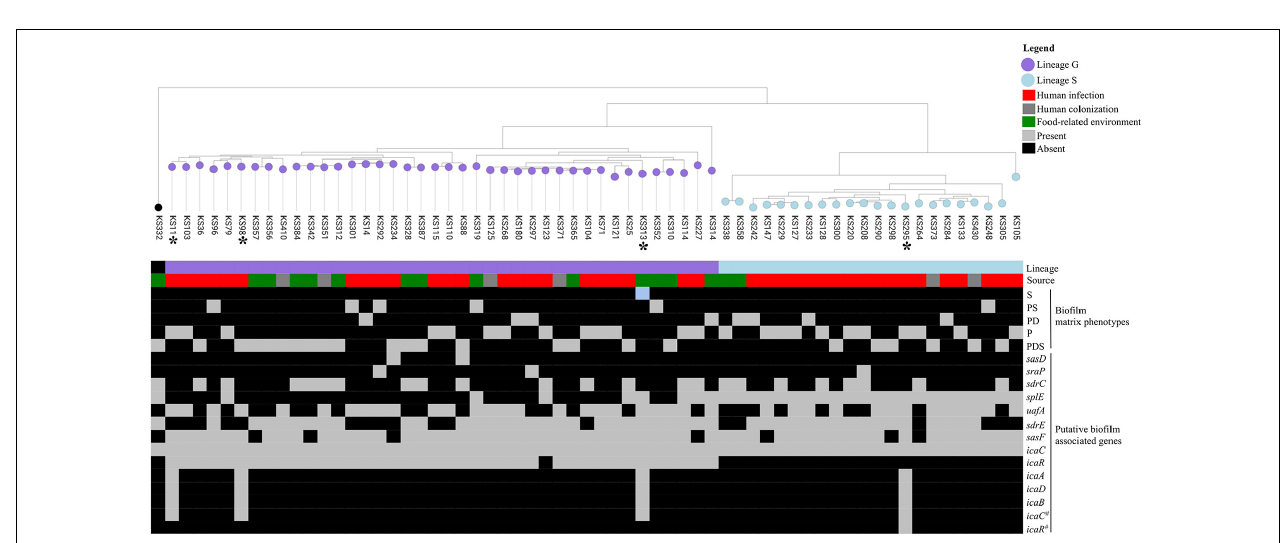
FIGURE 2 | Classification of the biofilm matrix phenotypes produced by Staphylococcus saprophyticus based on the (A) source and (B) genetic lineages of isolates. Associations of biofilm matrix phenotypes with S. saprophyticus isolates belonging to two different genetic lineages and recovered from different sources were tested using chi square at p < 0.05. The proportions of isolates of infection and colonization (A) and lineage G and S (B) that have a specific biofilm phenotype are shown.